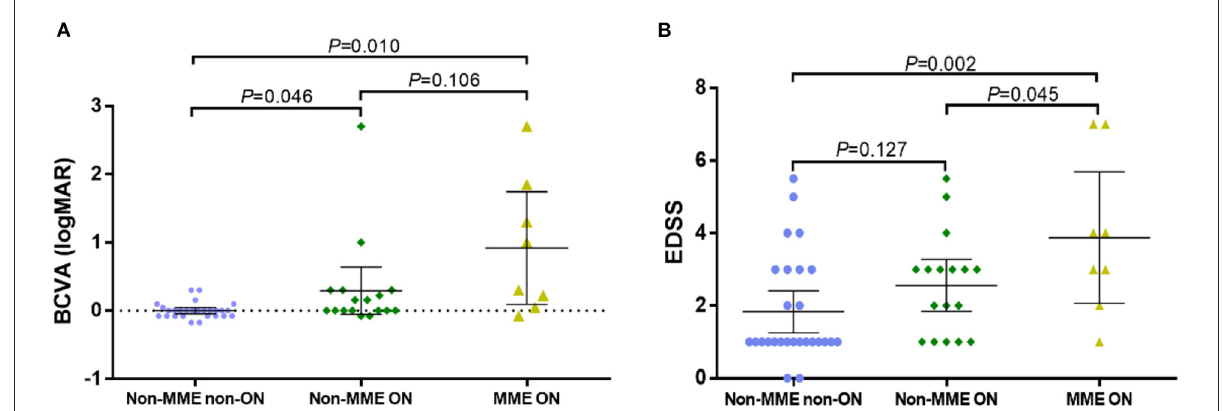
FIGURE2 Best corrected visual acuity (BCVA) and the score of Expanded Disability Status Scale (EDSS) in NMOSD patients with non-MME non-ON, non-MME ON and MME ON eyes. ON in NMOSD is associated with worse visual impairment (A) , and MME in NMOSD is related with greater